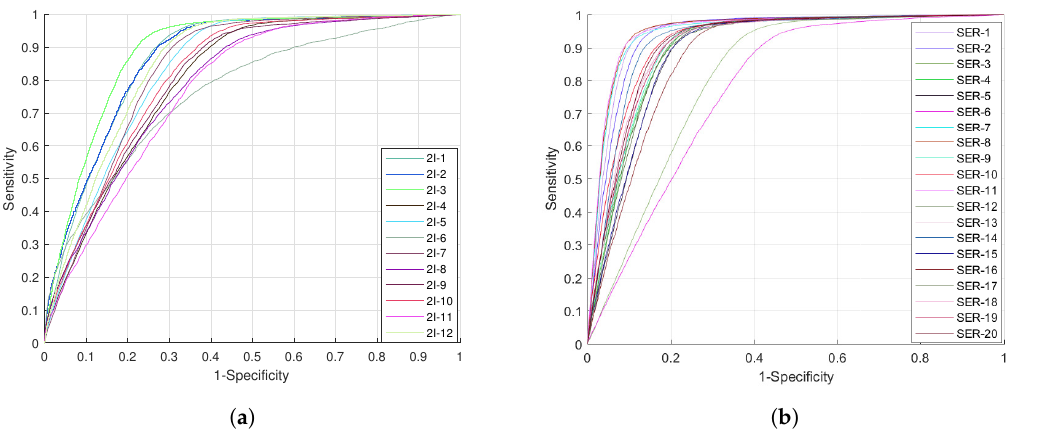
Figure 7. The ROC of our method on different cells. ( a ) The ROC on 2 i -cultured mESCs. ( b ) The ROC on serum-cultured mESCs.